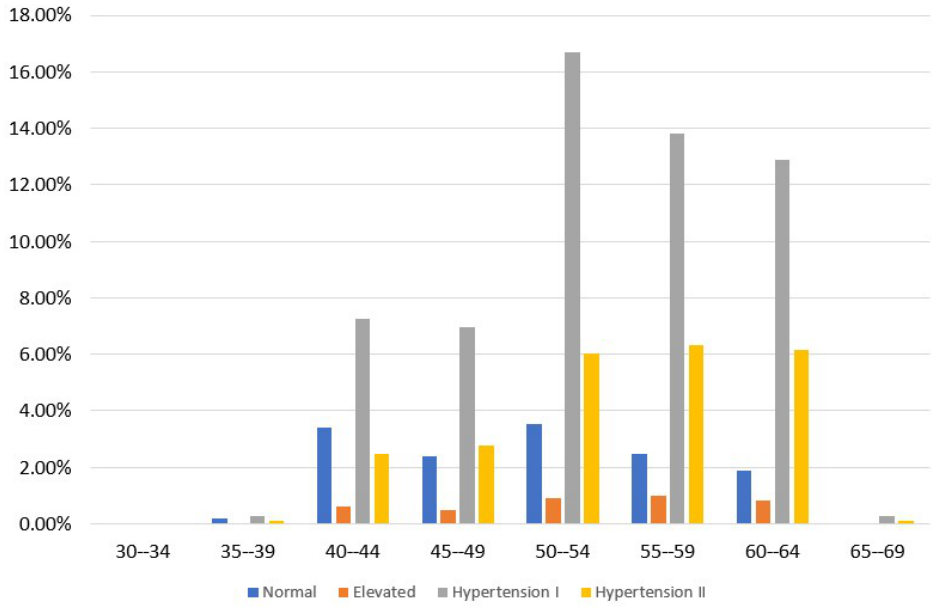
Figure 2. CVD participants’ distribution in terms of the age group and blood pressure category in the balanced dataset.